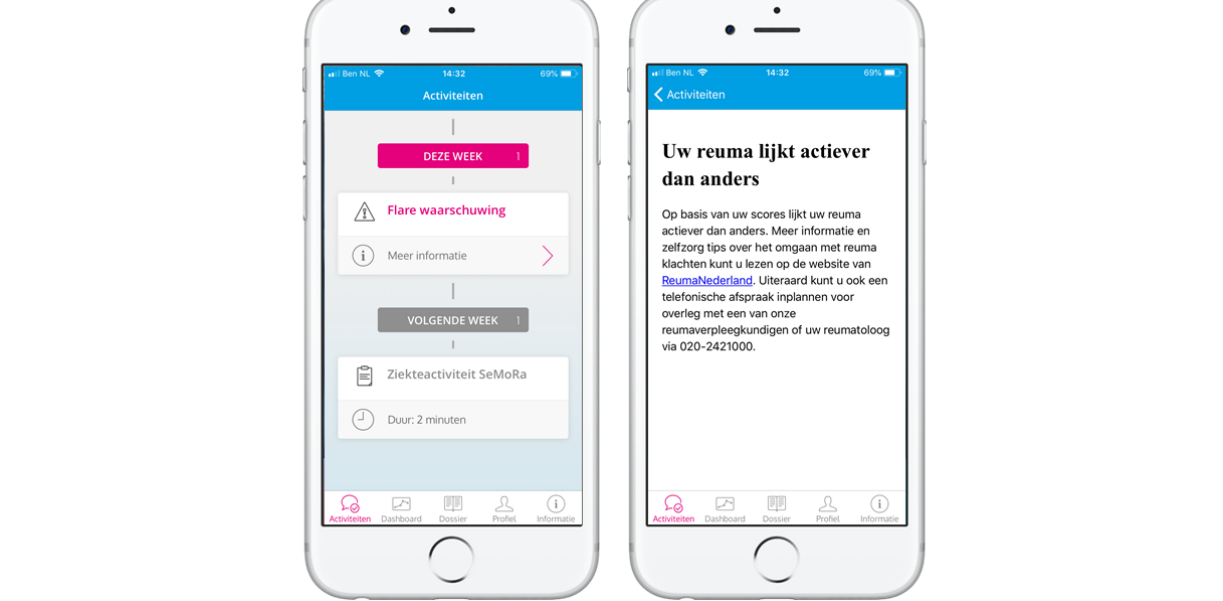
Figure 4. Flare algorithm. The app generates an alert with a link to self-management tips and advice to contact the outpatient clinic in case of an increased disease activity. Left: "Flare warning". Right: "Your disease appears to be more